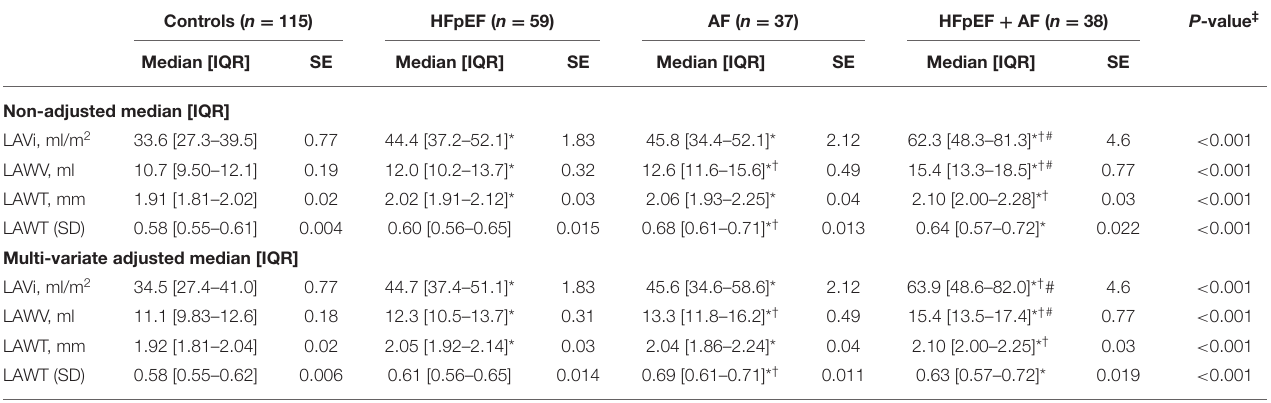
TABLE 2 | Baseline atrial structure and LA wall indices of the study subjects by MDCT. Controls ( n = 115) HFpEF ( n = 59)